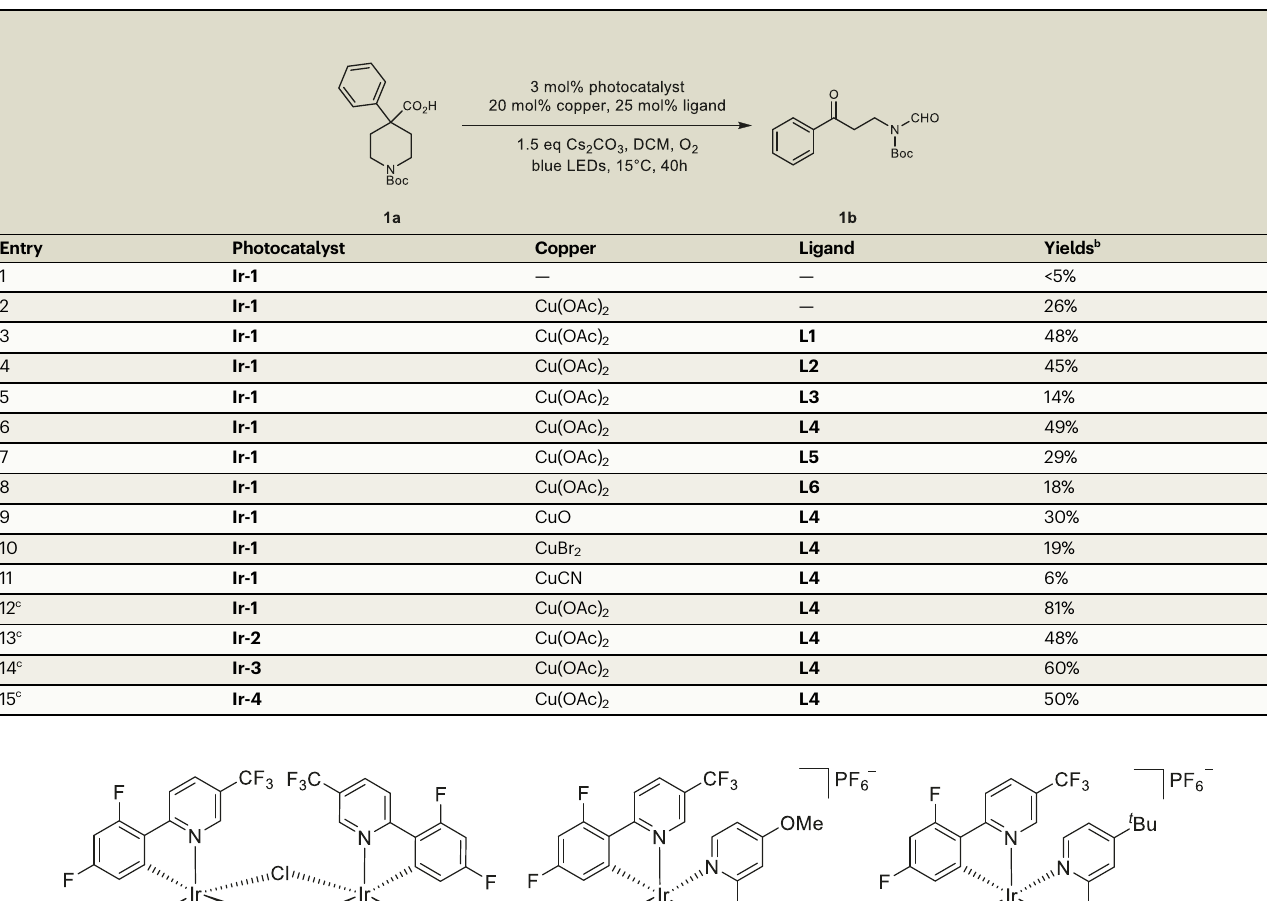
Table 1 | Optimization of the reaction conditions